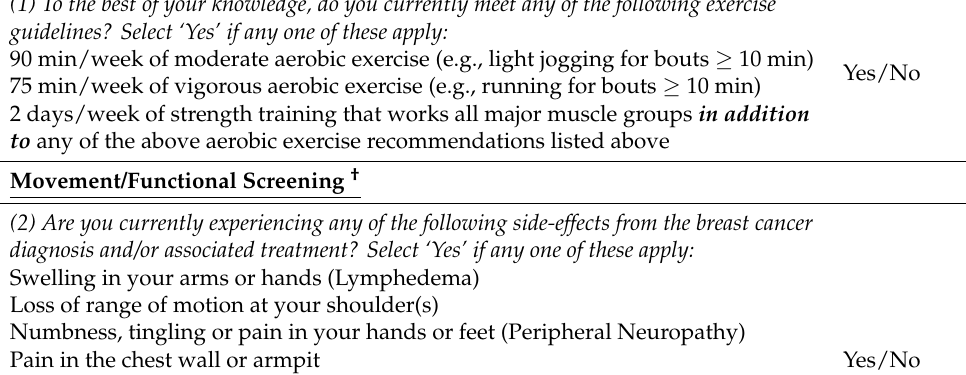
Table 3. Brief Physical Activity/Functional Screening Questionnaire. Physical Activity Screening